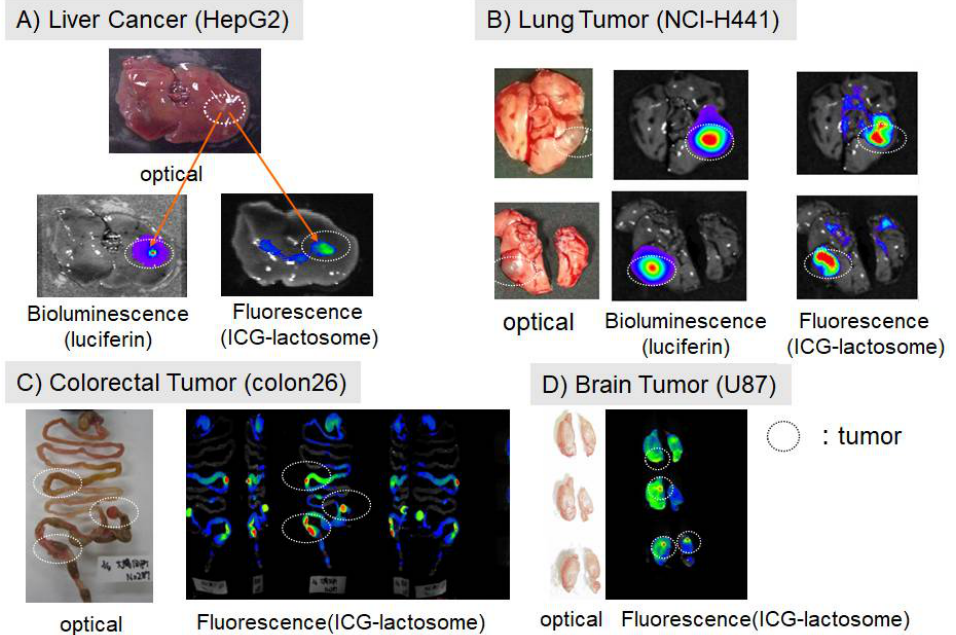
Figure 2. Accumulation of ICG-lactosomes in mouse cancer models. Images were obtained at 24 h after intravenous administration of ICG-lactosomes via the tail vein. The cancer cells carried the luciferase reporter gene. The ICG fluorescence sites overlapped at the luciferin bioluminescence sites, which are a marker of cancer cells. Cancer tissue was confirmed by luciferin bioluminescence and macroscopic findings. (Reproduced from Ozeki and Hara [17]).